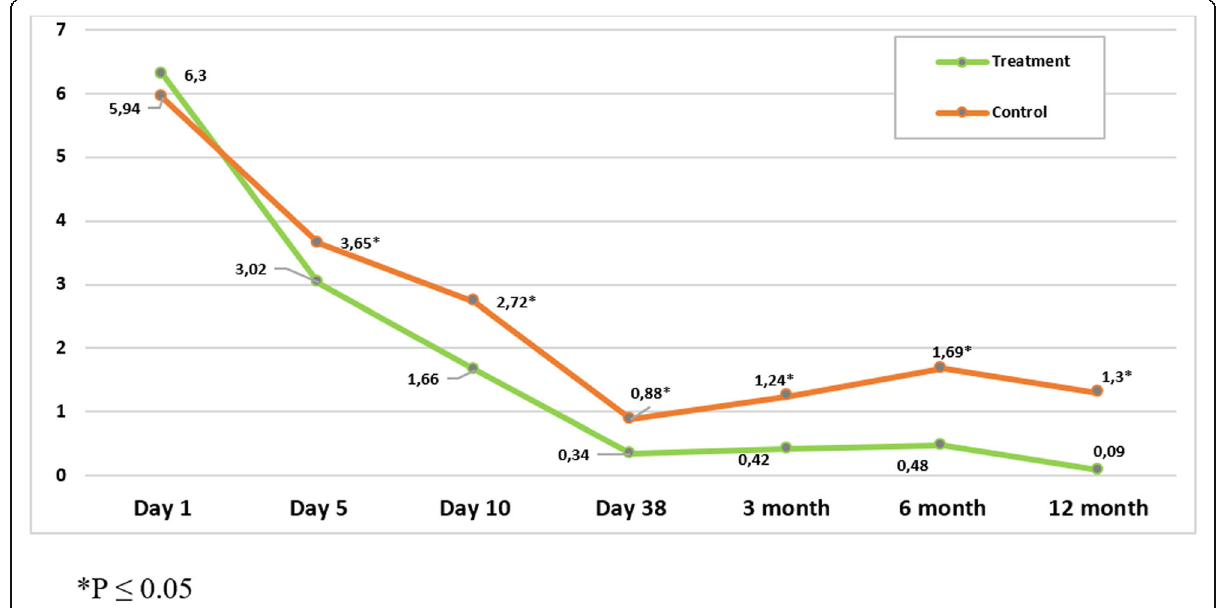
Fig. 3 Dynamics of the indicator “ Patient self-assessment